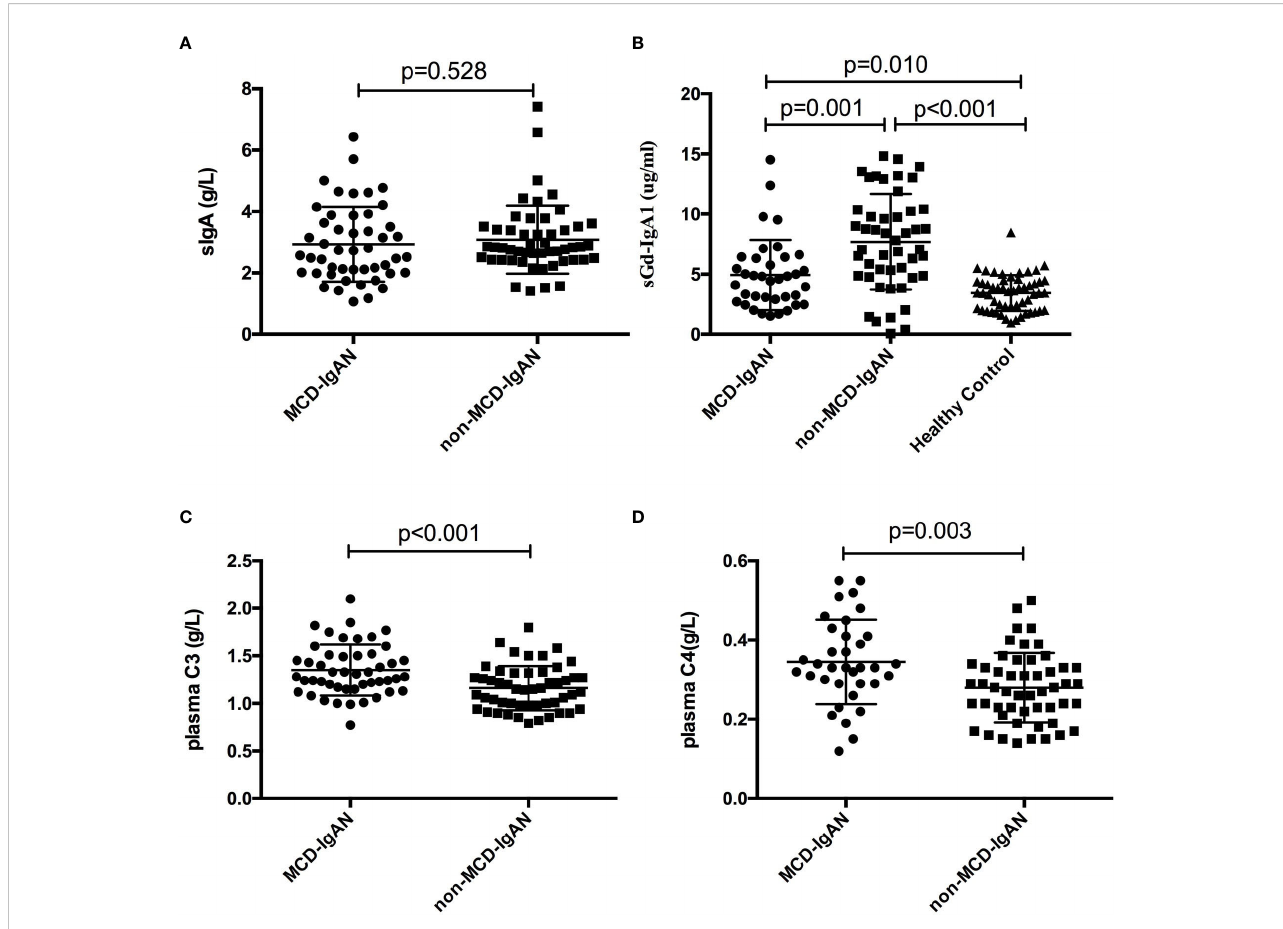
FIGURE 3 Levels of serum galactose-de fi cient immunoglobulin A1 (Gd-IgA1) and immunoglobulin A (IgA), plasma component 3 (C3) and C4 in the minimal change disease (MCD)-immunoglobulin A nephropathy (IgAN) group and non-MCD-IgAN group. (A) There was no difference between the MCD-IgAN group and non-MCD-IgAN group in the level of serum immunoglobulin (IgA). (B) The level of serum Gd-IgA1 in the MCD-IgAN group was lower than in the non- MCD-IgAN group, but higher than in the healthy control participants. The levels of plasma complement C3 (C) and complement C4 (D) were higher in the MCD-IgAN group than in the MCD-IgAN